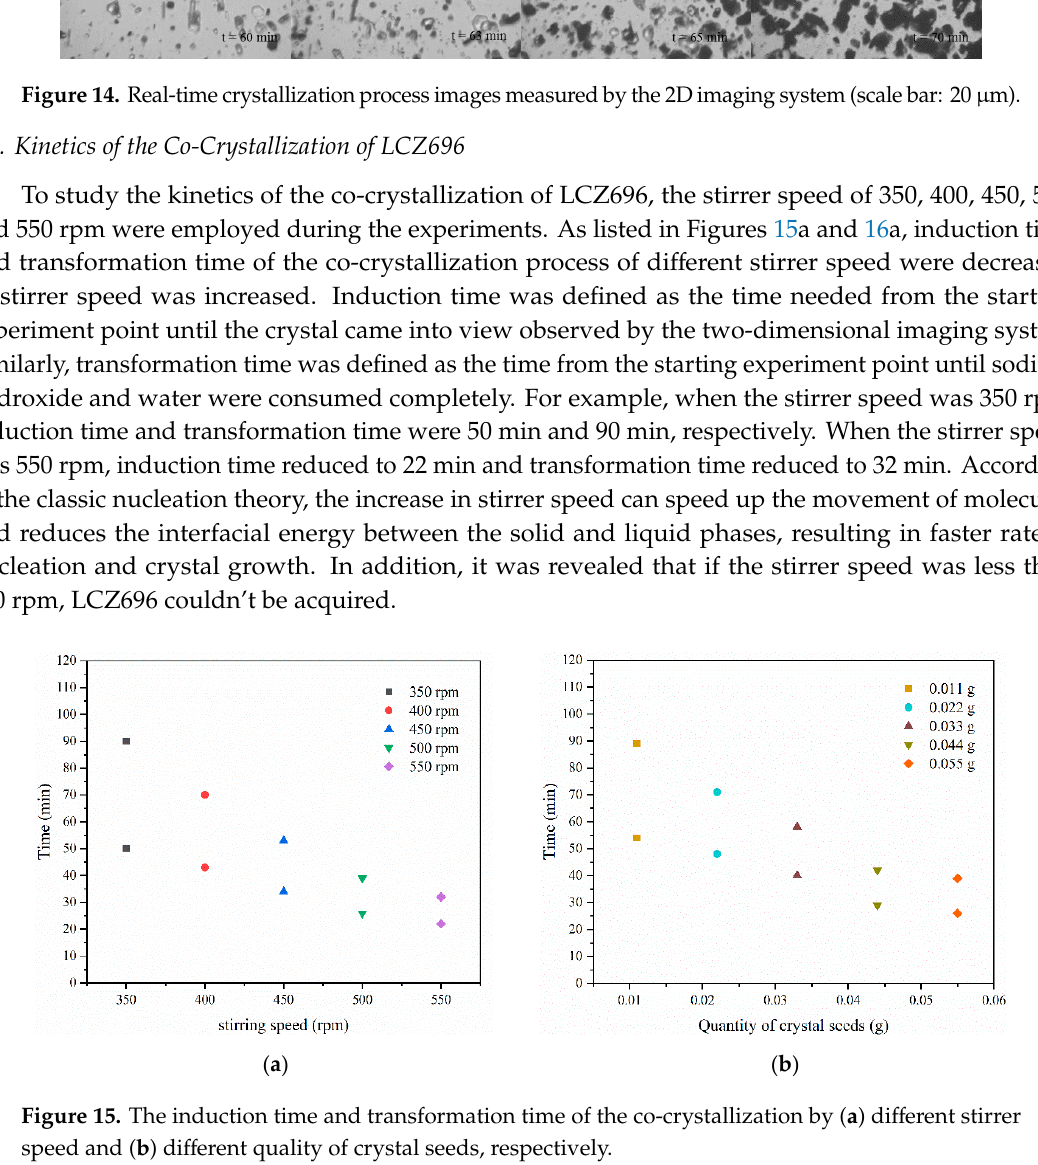
Figure 16. The concentration variation of sacubitril during the co-crystallization of LCZ696 by ( a ) different stirrer speed and ( b ) different quality of crystal seeds, respectively.